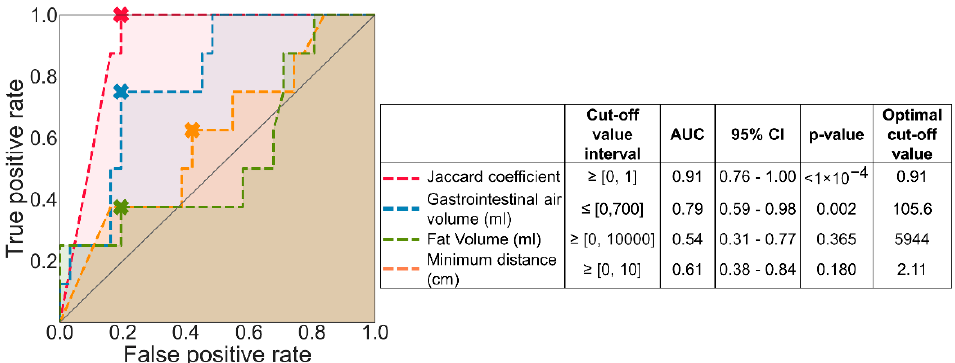
Figure 4. ROC curve analysis of each predicted condition. The cross marked in each curve indicates the optimal cut-off value, and the shade under each represents AUC. The identity line presented by a solid grey line represents the ROC curve with an AUC equal to 0.5.